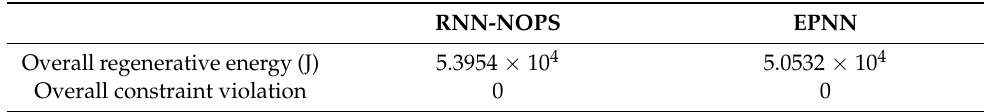
Table 3. Overall results under the designed braking process in terms of regenerative energy and constraint violation.